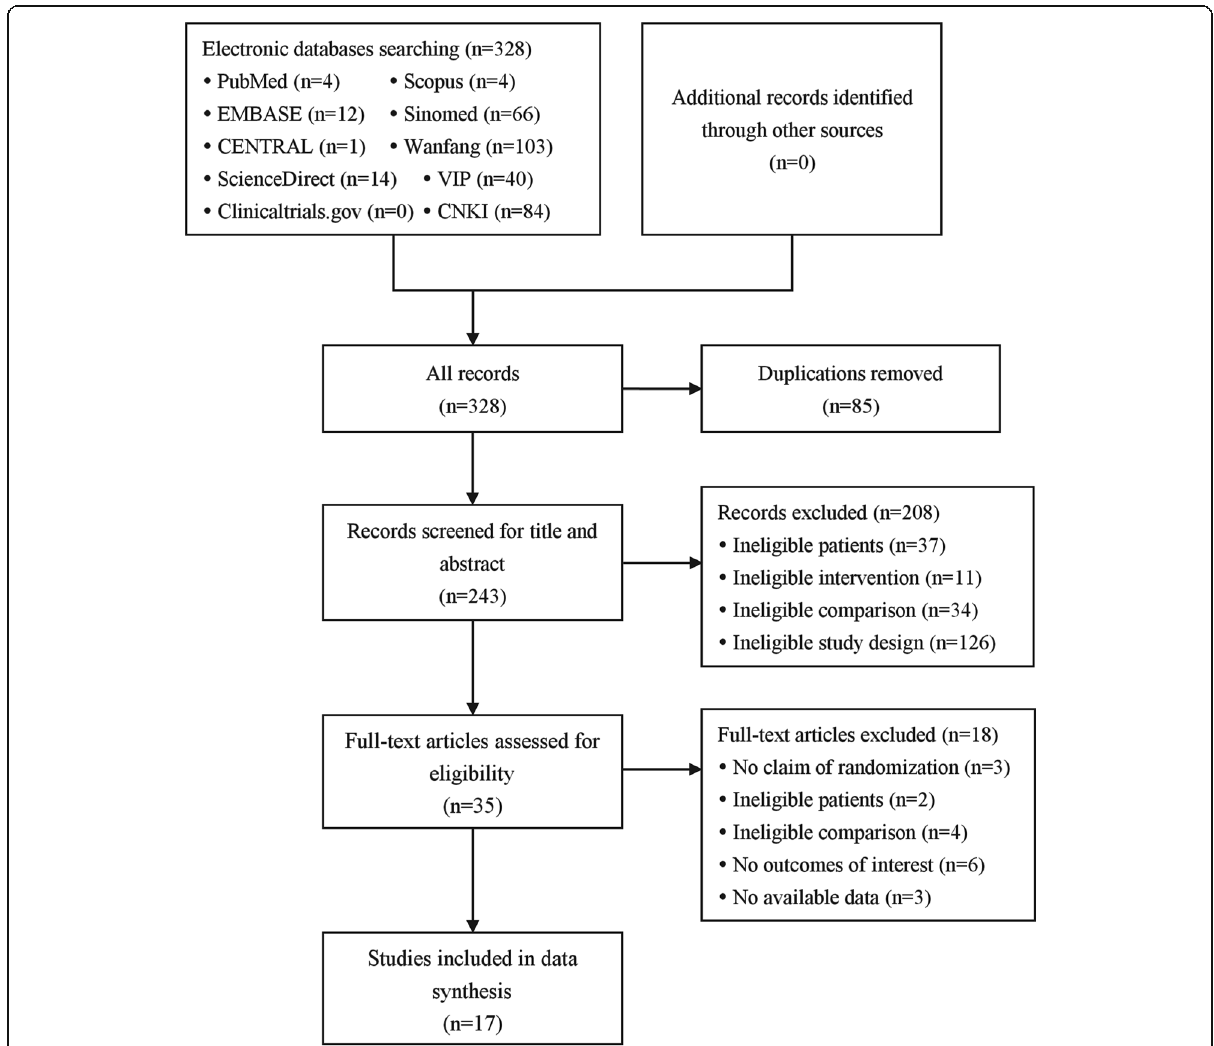
Fig. 1 Flowchart of study